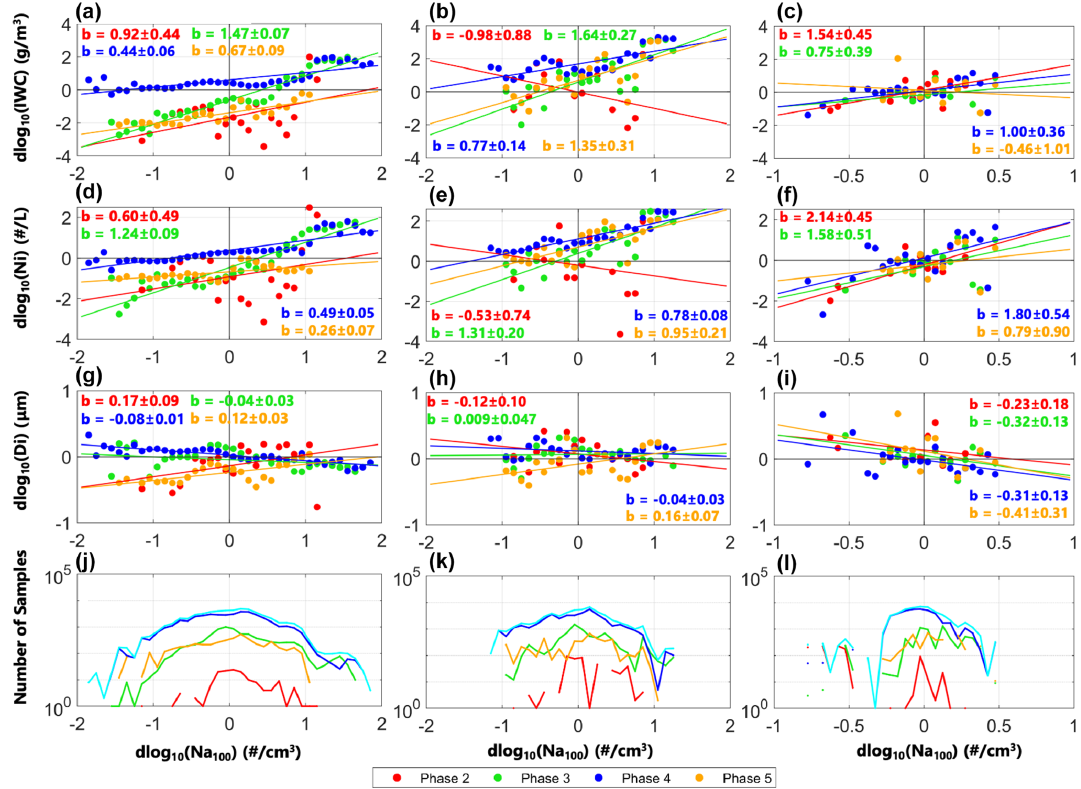
Figure 12. Similar to Fig. 10, except for using two NASA flight campaigns to analyze linear regressions with respect to dlog 10 (Na 100 ).